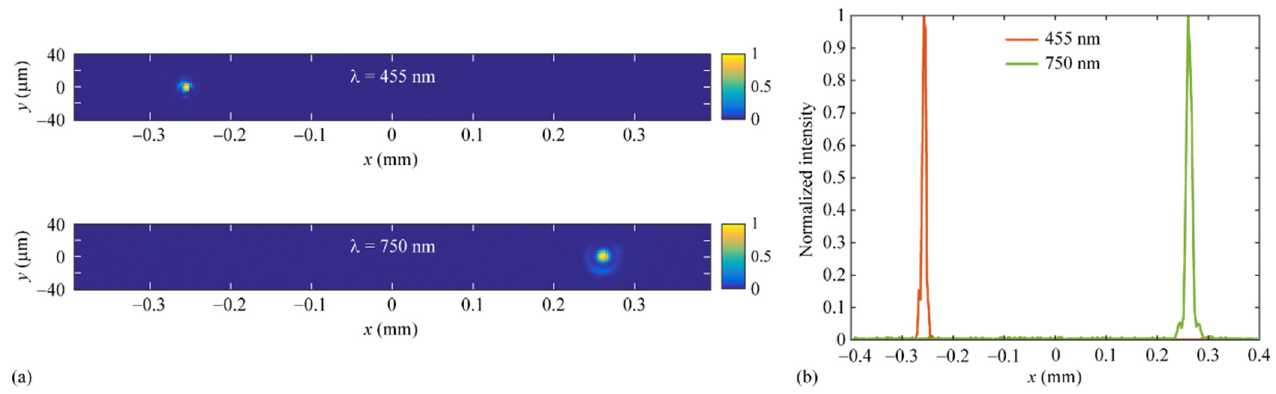
Figure 9. ( a ) Normalized measured two-dimensional intensity distributions generated by the fabricated MWDL [Figure 7a] at the design wavelengths λ 1 = 455 nm and λ 2 = 750 nm; ( b ) Cross-sections